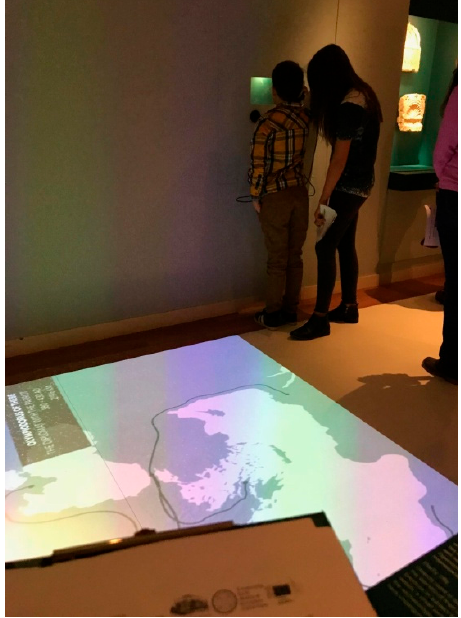
Figure 6. Small holographic showcase at APM during the CEMEC traveling exhibition, with visitors paying attention at the multimedia content inside of it.